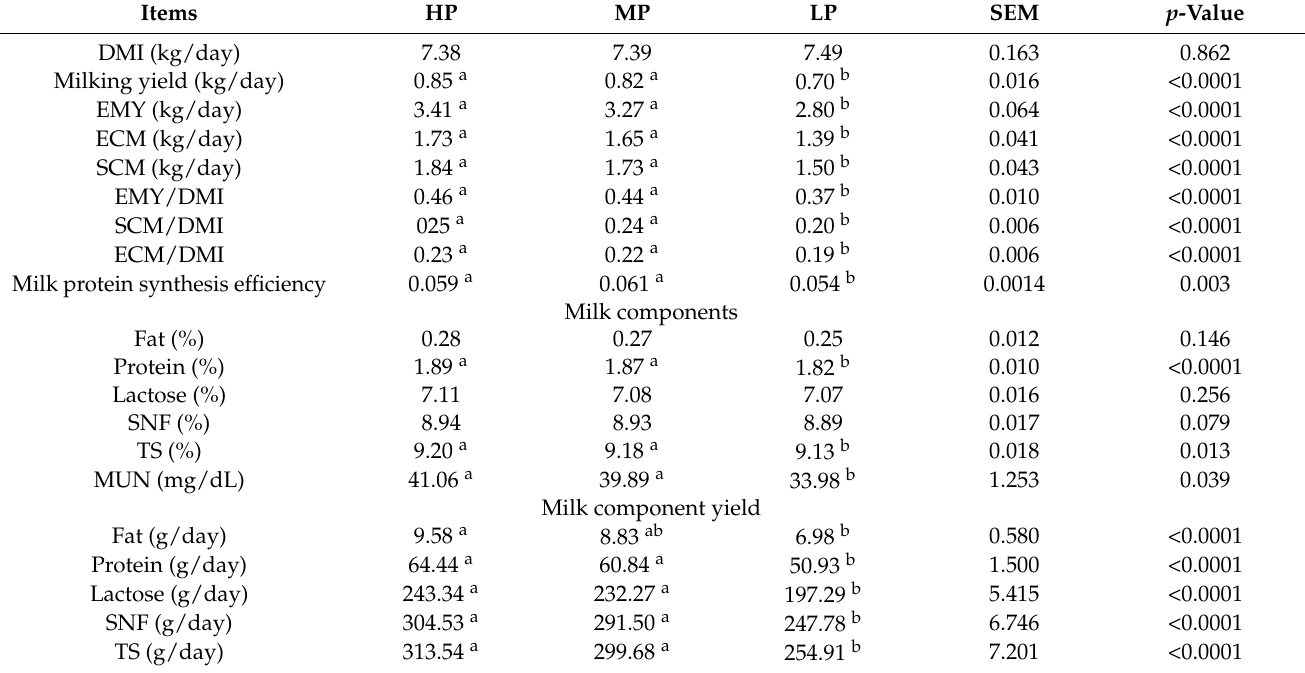
Table 2. Effects of dietary crude protein levels on DMI, feed conversion rate, milk protein synthesis efficiency, milk yield, content and yield of milk components of lactating donkeys.